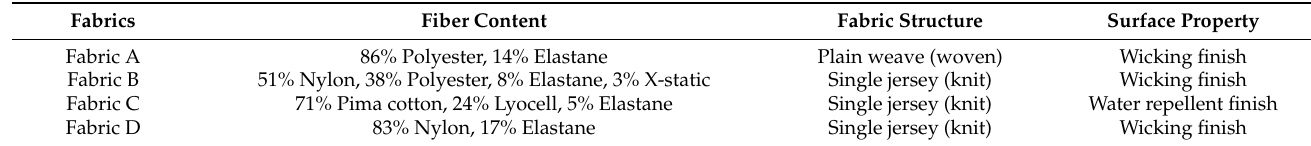
Table 1. The fiber content and the structural features of the fabric systems.